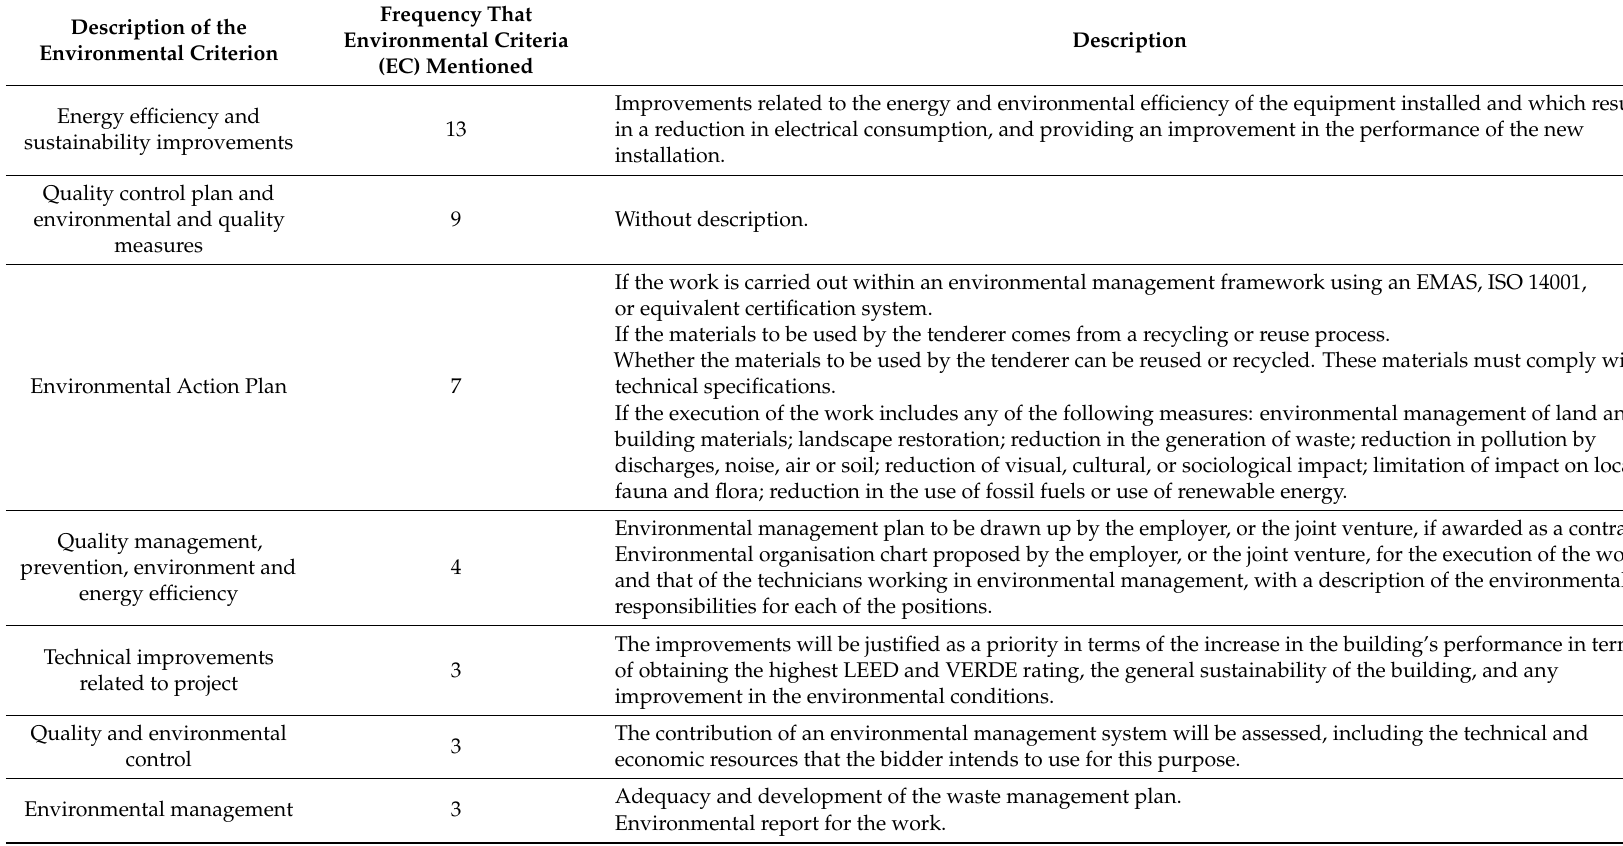
Table 3. Environmental criteria and its description in the study